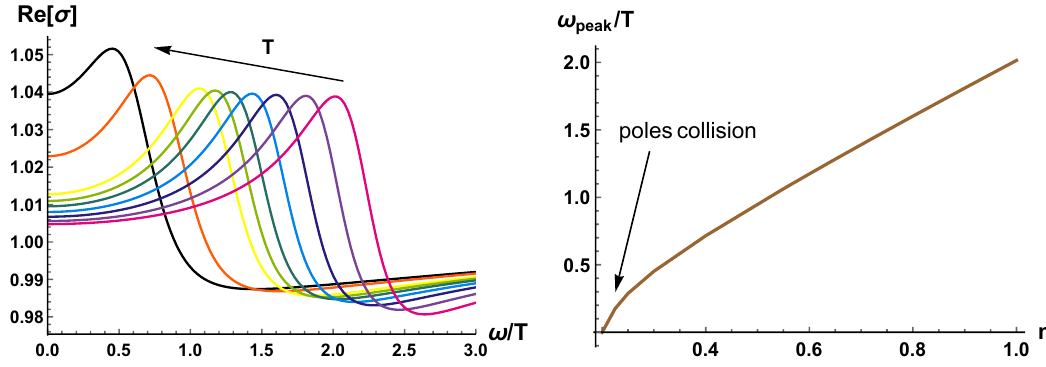
Figure 9 . The behaviour of the o(cid:11)-axes peak in function of the dimensionless temperature. We (cid:12)xed (cid:12) = 10 and we dial m=T 2 [0 : 2 ;